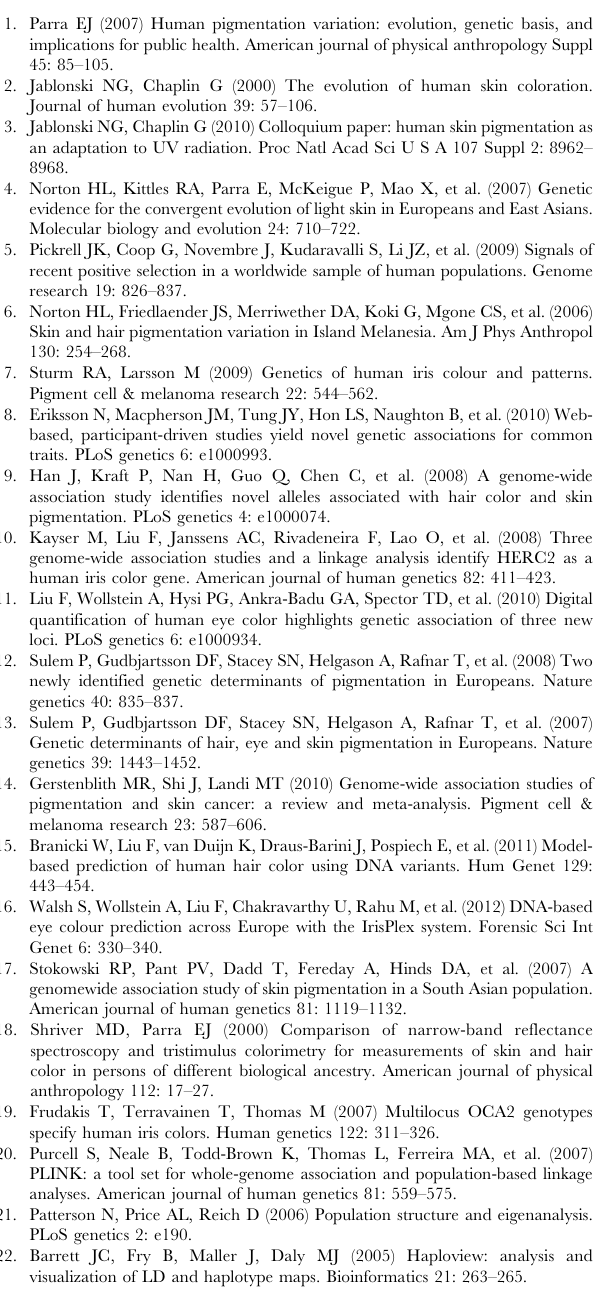
Table S1 Differences in pigmentation between coun- tries and sexes (p-values from a linear model). Table S2 Correlations between phenotypes (Pearson correlations and p-values from a linear model in parentheses). Table S3 GWAS, replication, and combined association results for all signals with p-value , 10 2 4 in the